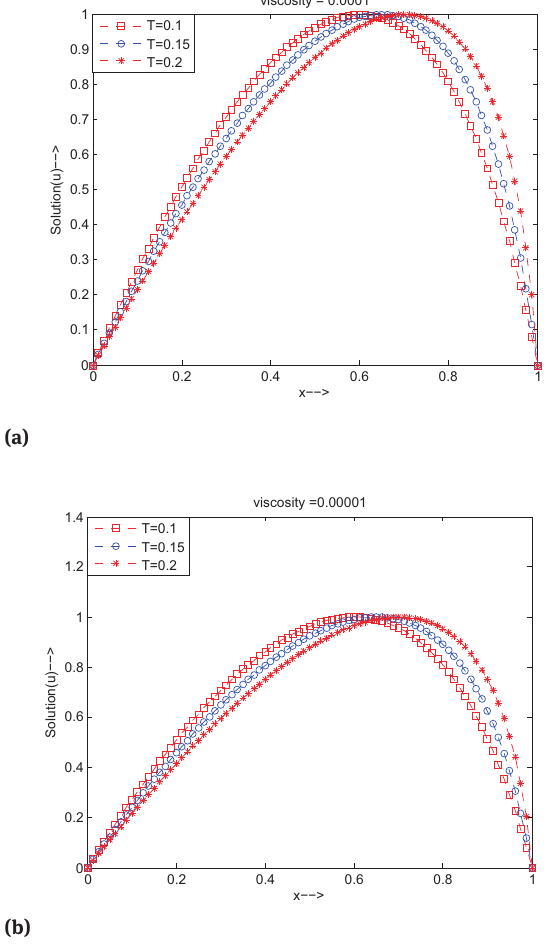
Fig. 6: Example 2: Physical behavior of numerical solutions at dif- ferent times with Δx = 0.0125 and Δt = 0.001 . (a) ν = 0.0001 (b) ν = 0.00001 . Table 11: Numerical solutions obtained by proposed schemes and the exact solutions for Example 3: ν = 0.02 , Δx = 0.0125 and Δt = 0.001 .